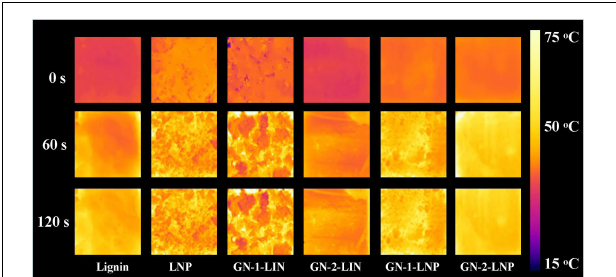
FIGURE 7 | Temperature distributions in the samples during heating.